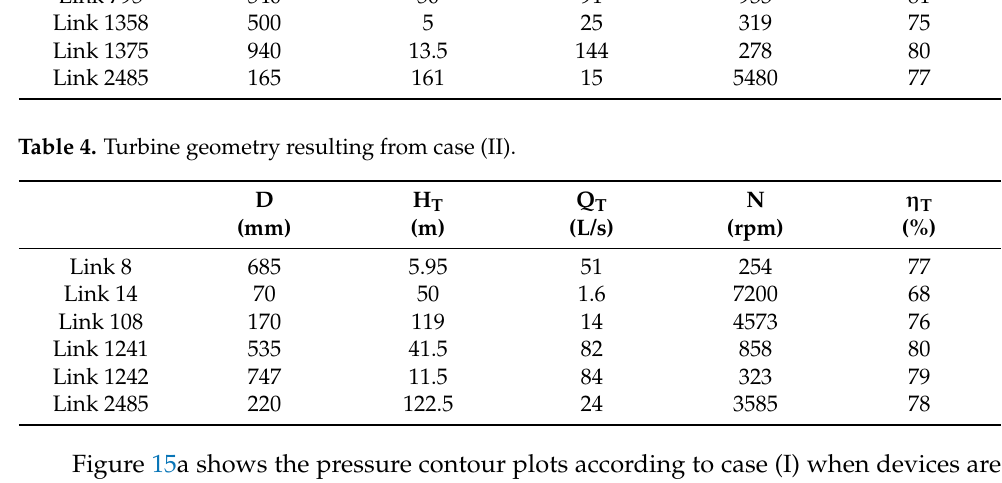
Table 4. Turbine geometry resulting from case (II).